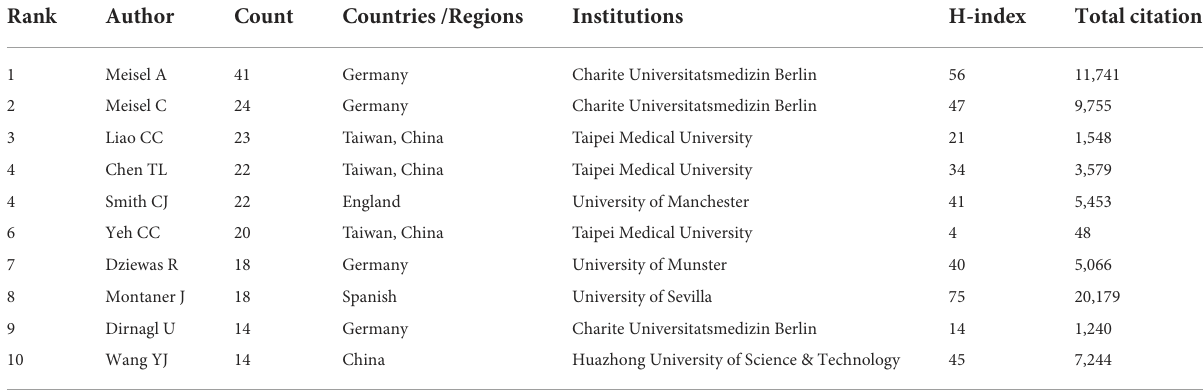
TABLE 3 The top 10 most productive authors in the field of post-stroke